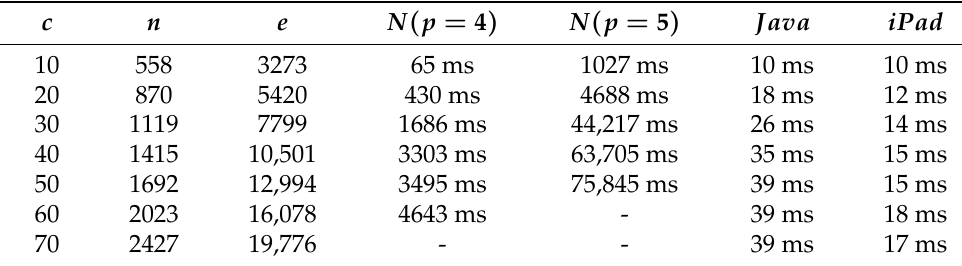
Table 3. Scalability with the DIV2K dataset.